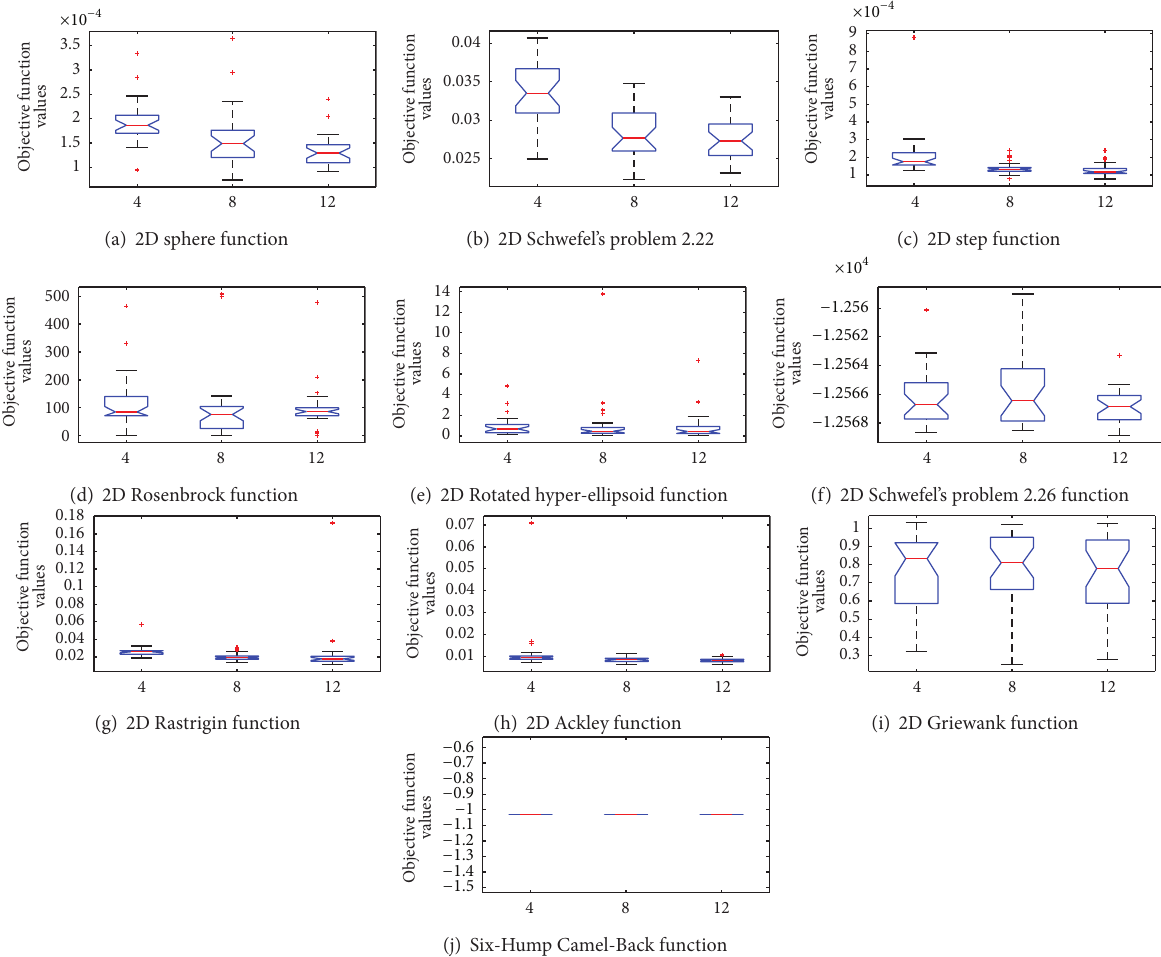
Figure 11: The box plots for showing the effect varying NH values using the ten global optimization functions.